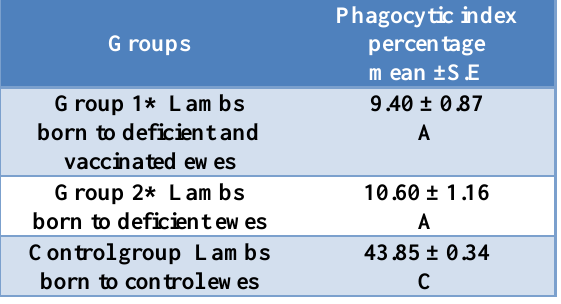
Table, 3: The mean percentage of phagocytic activity in newborn lambs (control and Vit. E and selenium deficient.